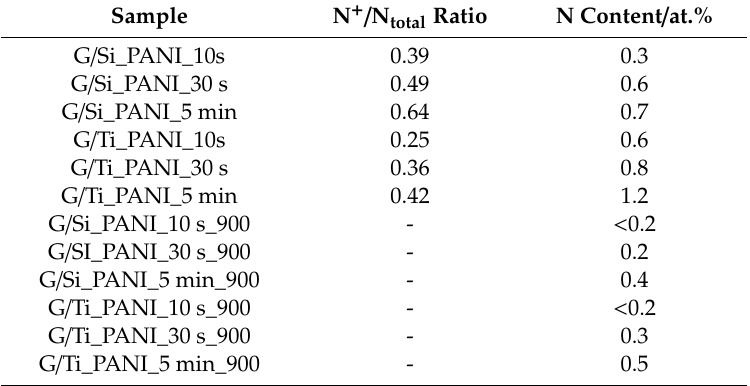
Table 2. Ratio between positively charged nitrogen species and total nitrogen content and the atomic percentage of the nitrogen content obtained from XPS.